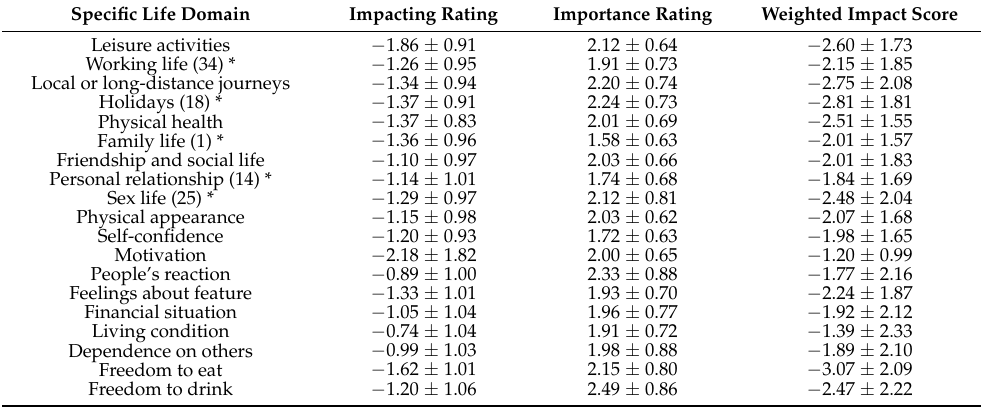
Table 3. Patients’ responses to the Romanian version of the Audit of Diabetes Dependent Quality of life